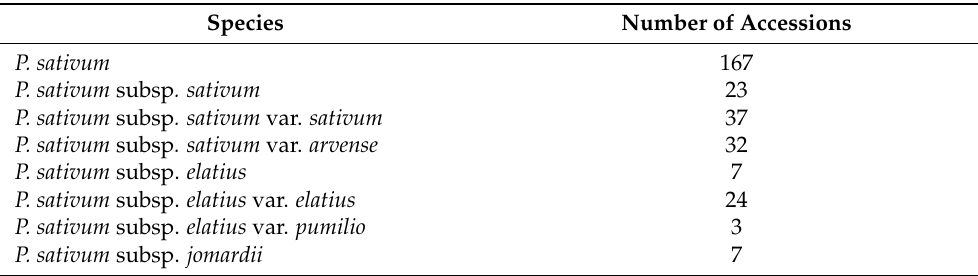
Table 1. Composition of the Pisum core collection according to the original passport data from germplasm